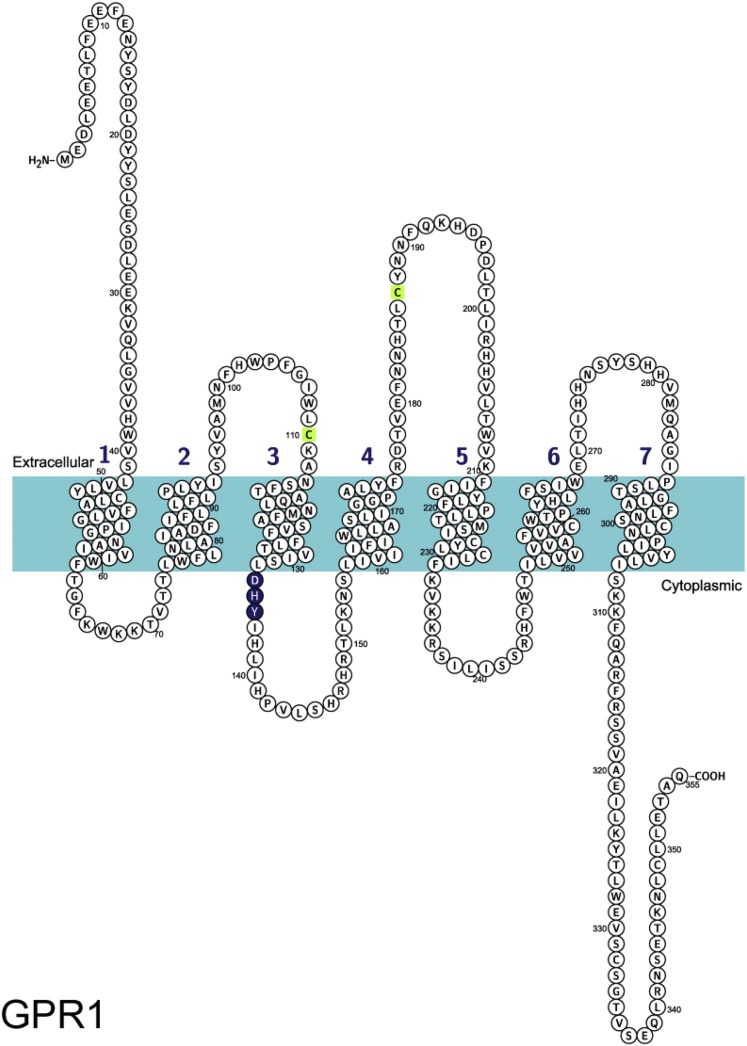
Amino acid sequence of chemerin receptor 2: Cys110 and Cys187 (green) are predicted to form a disulfide bond based on sequence similarity, and the G protein–binding motif is shown in blue. Figure made using UniProt (P46091) and Protter (Omasits et al., 2014).